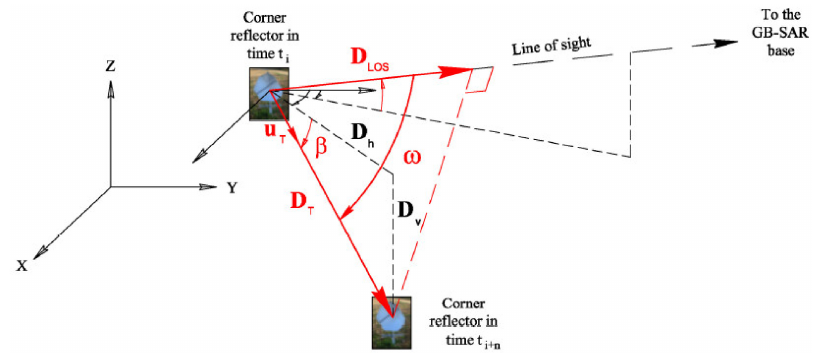
Figure 25. The GBSAR total displacement, D T , is computed from D LOS using the 3D average direction derived from GPS (unit vector U T )